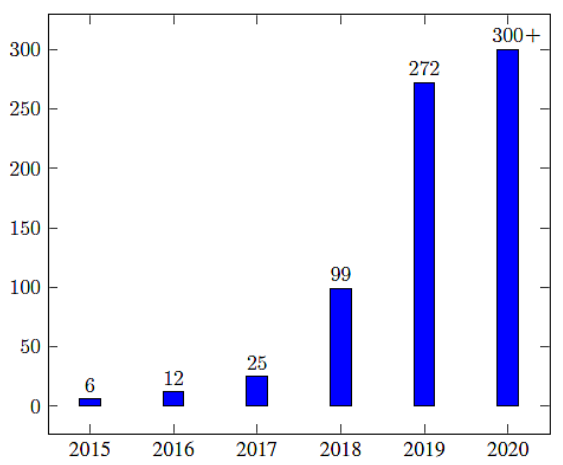
Figure 7. A bar graph of the number of papers published fully (or partially) in the context of B5G and/or 6G networks over the last few